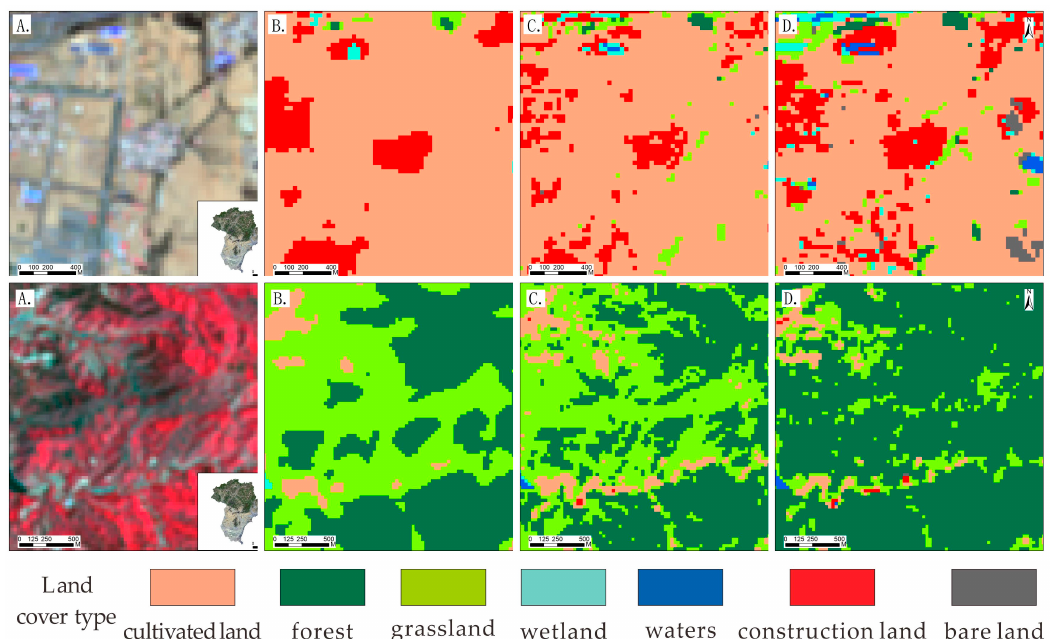
Figure 8. Comparison of three methods used for the detailed identification of artificial land in the south and forest land in the north (A: Landsat 8 OLI (RGB: Bands 5, 4, 3), B: DCNN, C: SVM, and D: MLC).